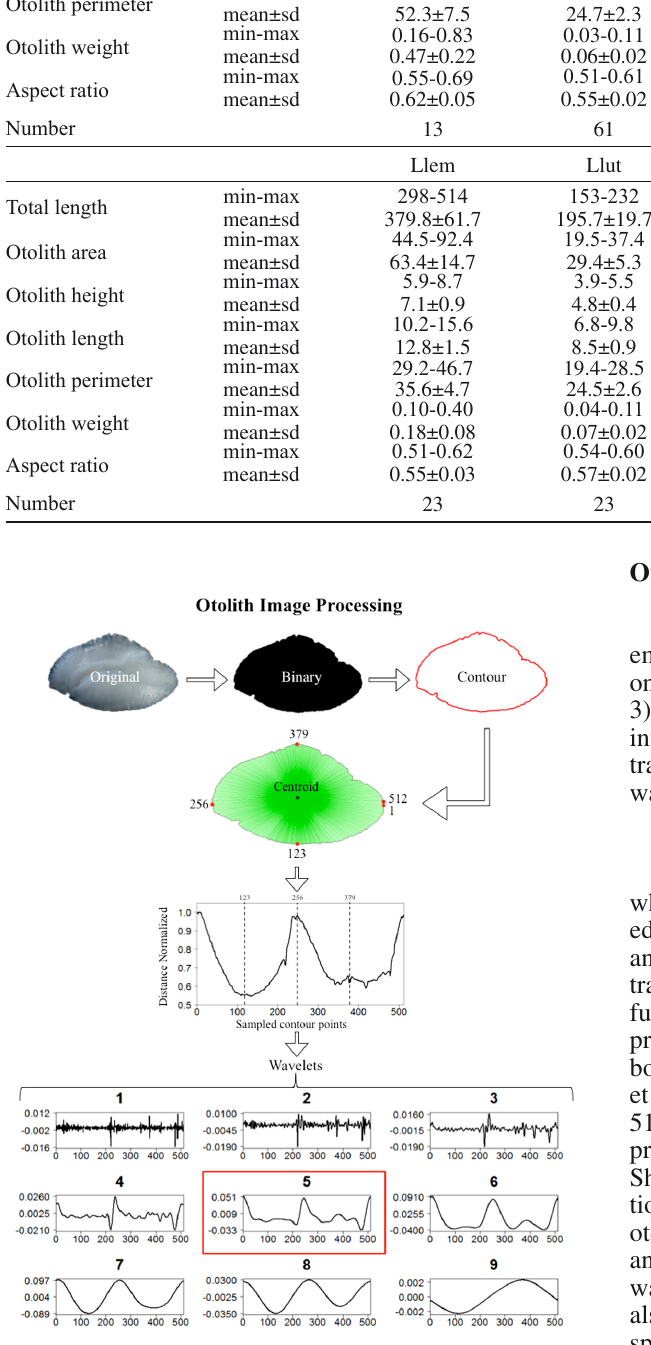
Fig . 3. – Scheme showing the procedure for obtaining